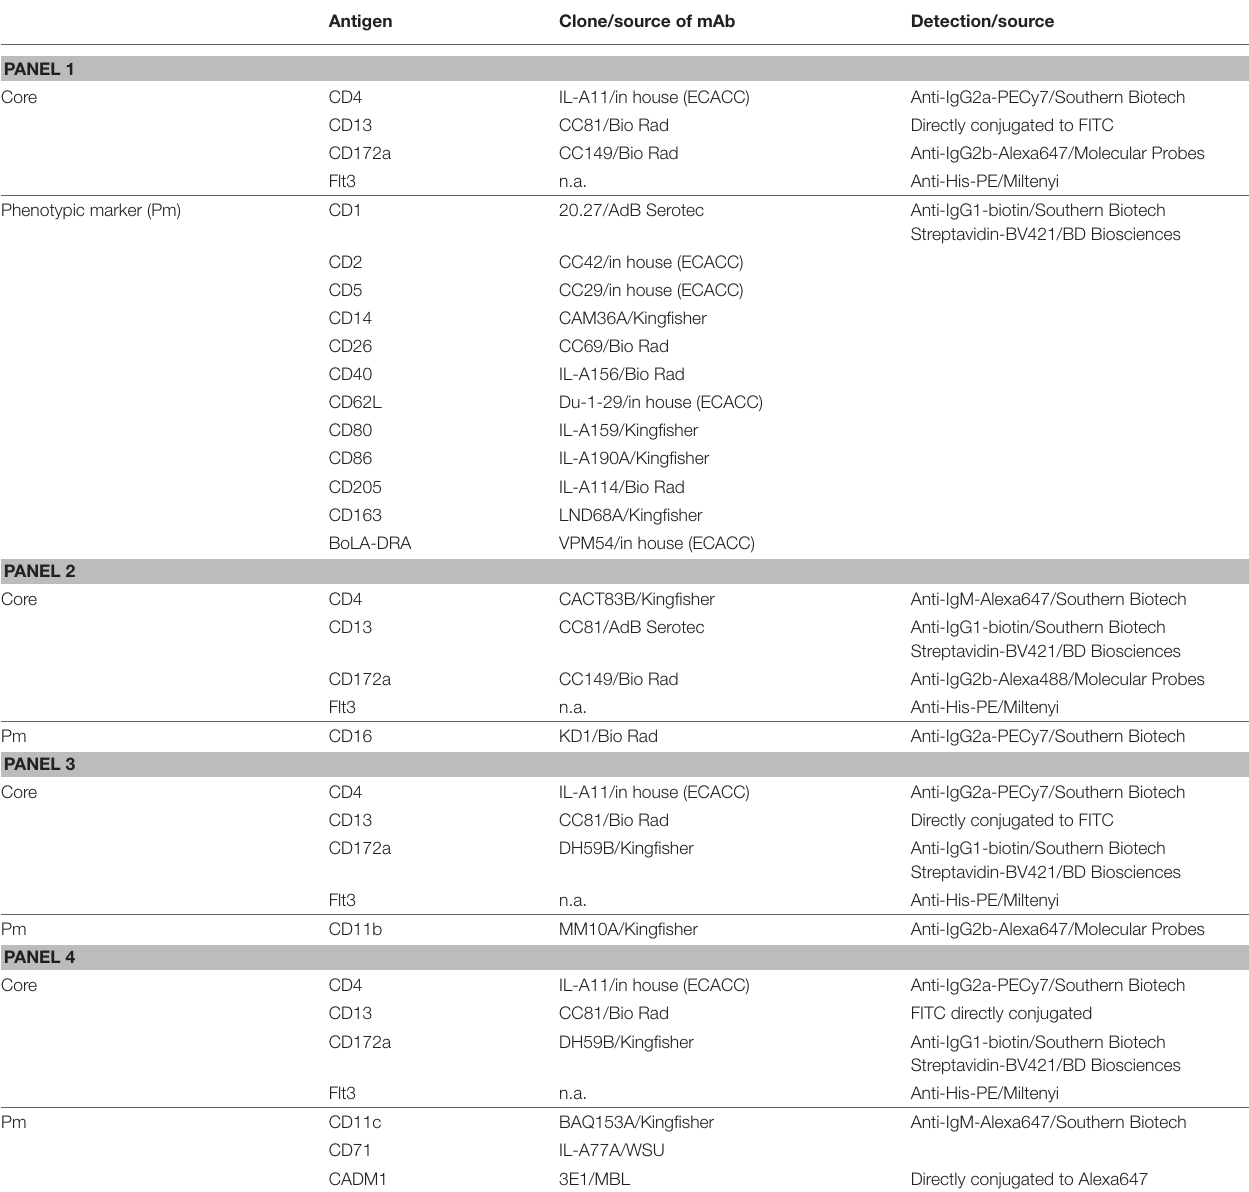
TABLE 1 | Antibodies and reagents used for flow